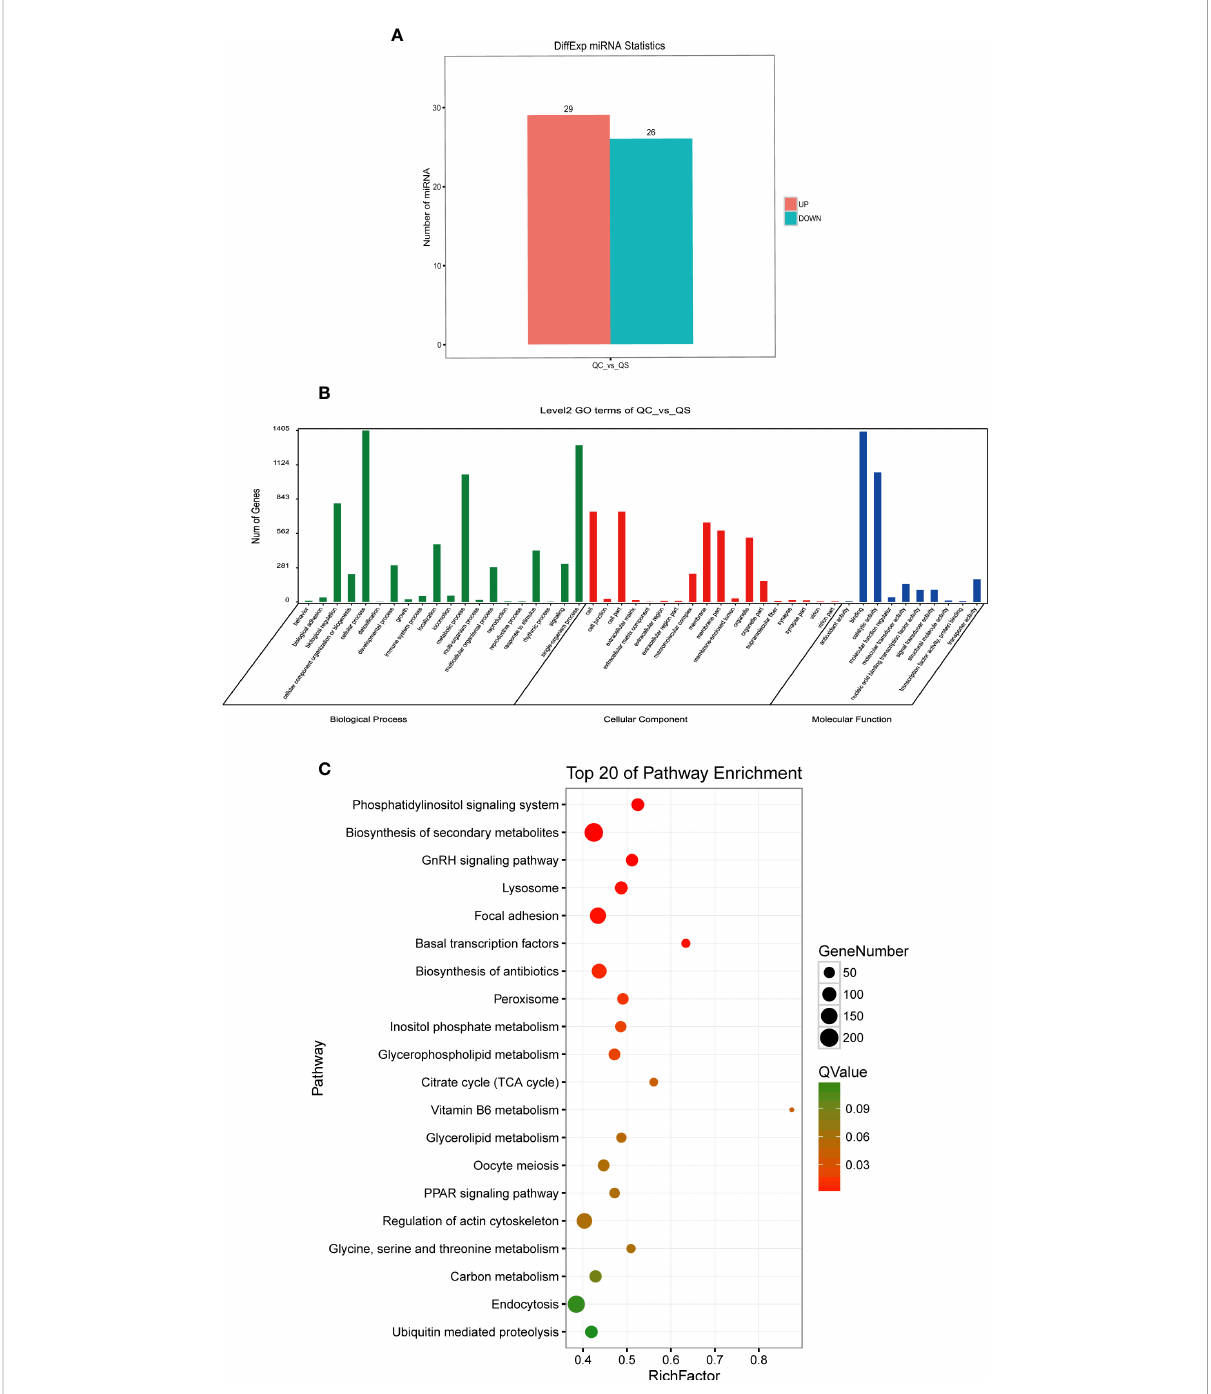
FIGURE 4 Identi fi cationand functionalannotationofdifferentiallyexpressedmiRNAs. (A) HistogramshowsdifferentiallyexpressedmiRNAs.Blueandpinkindicate decreasedand increasedexpression, respectively. (B) GO enrichment analysisofpredictedtargetgenesofDEMs. Theabscissaindicates 3ontologies (molecularfunction, cellularcomponentandbiological process)with 48 GOterms,theverticalcoordinate indicatesthegenescount. (C) KEGGpathway analysisoftarget genesof DEMs.The redderbubbleindicatesmoreobviousenrichment, withsmaller Q-value . Sizeof thepointreferstothe numberof genes within eachpathway. DEMs, differentiallyexpressedmiRNAs;DEGs, differentially expressedgenes;GO, GeneOntology;KEGG, KyotoEncyclopedia ofGenesand